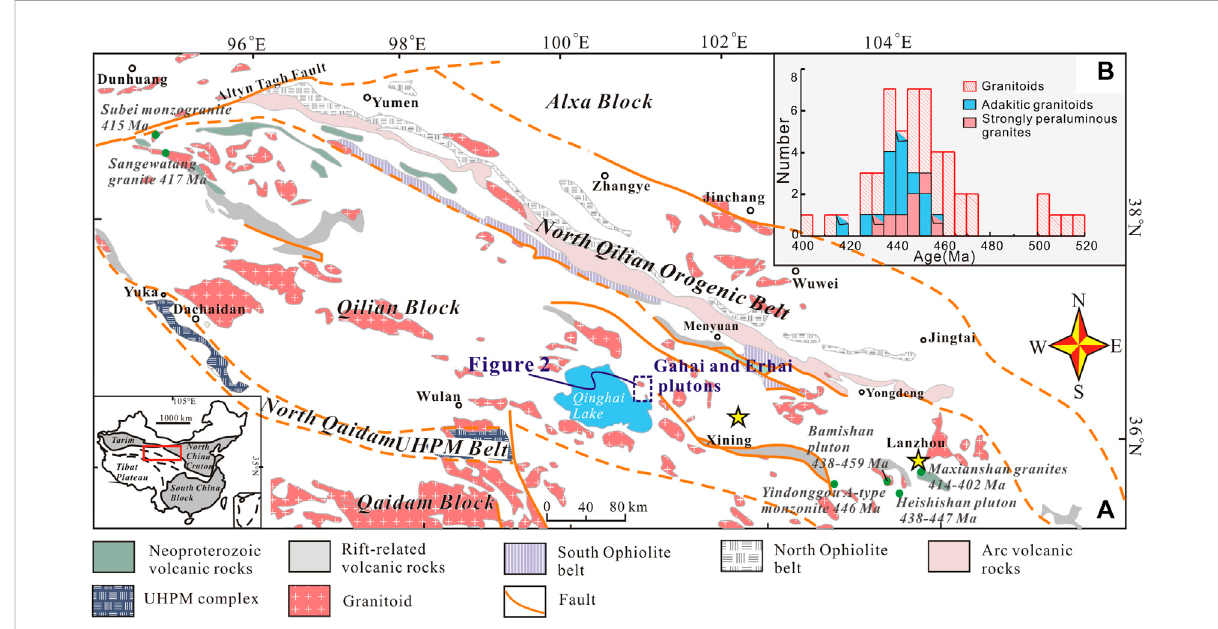
FIGURE 1 (A) GeologicalsketchmapoftheQilianorogenicbeltshowingdistributionsofearly – middlePaleozoicmagmaticrocksandtheirages(modi fi ed from Xia et al., 2016). Zircon U – Pb ages in previous studies are from Cui et al. (2019), Wang et al. (2017), Tung et al. (2016) and Yang et al. (2015) (B) Frequency of zircon U – Pb ages for the magmatic rocks from the eastern Qilian Block (modi fi ed from Zhao et al.,